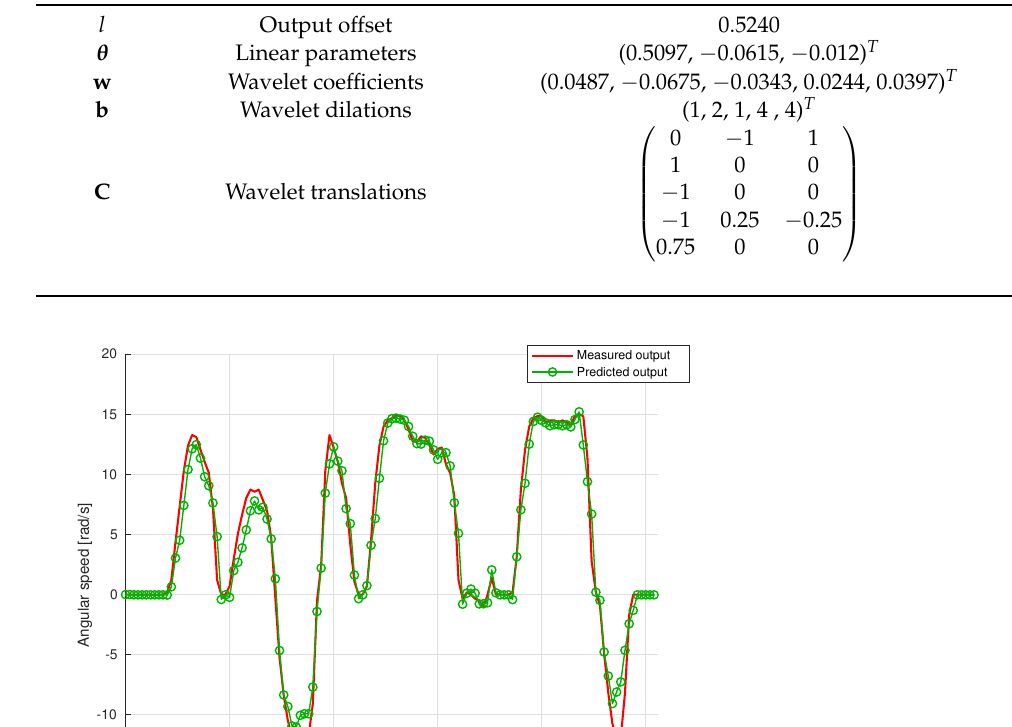
Table 1. WANARX parameters.